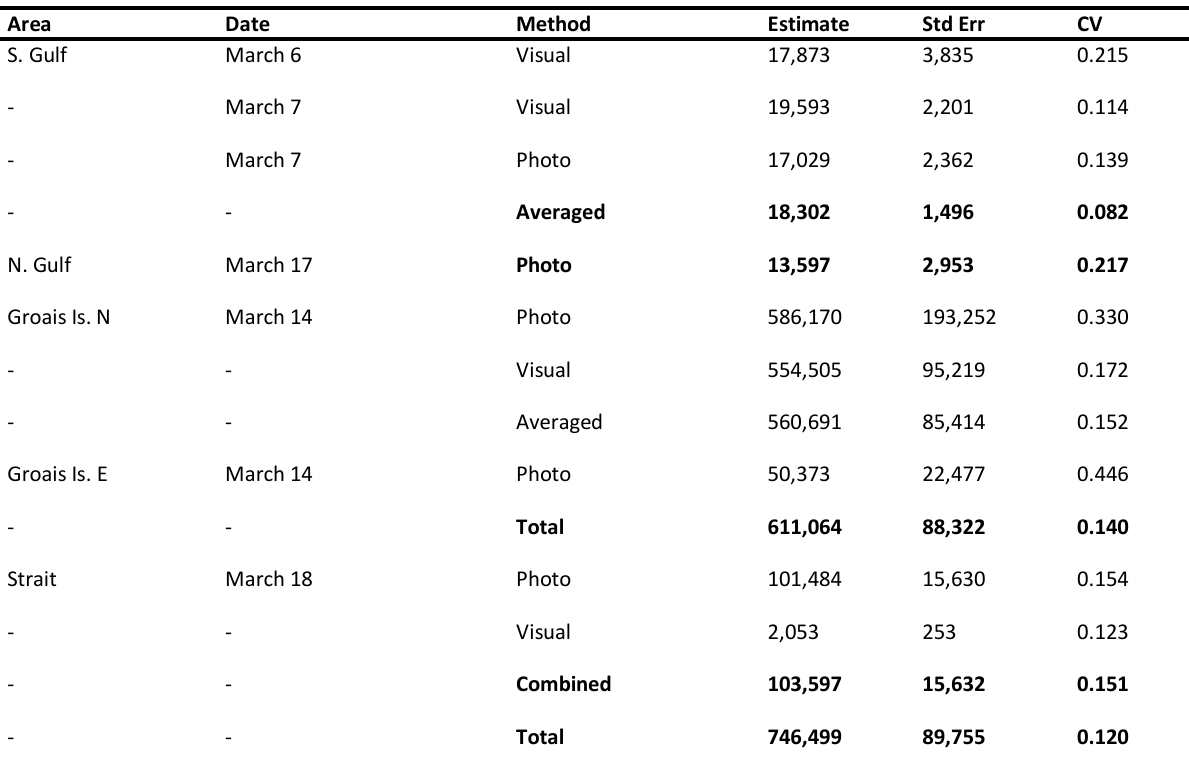
Table 3. Estimated pup production and standard errors of Northwest Atlantic Harp Seals during March 2017. The southern Gulf surveys are corrected for the estimated numbers of pups that may have been born after the survey. Estimates in bold are used in the final